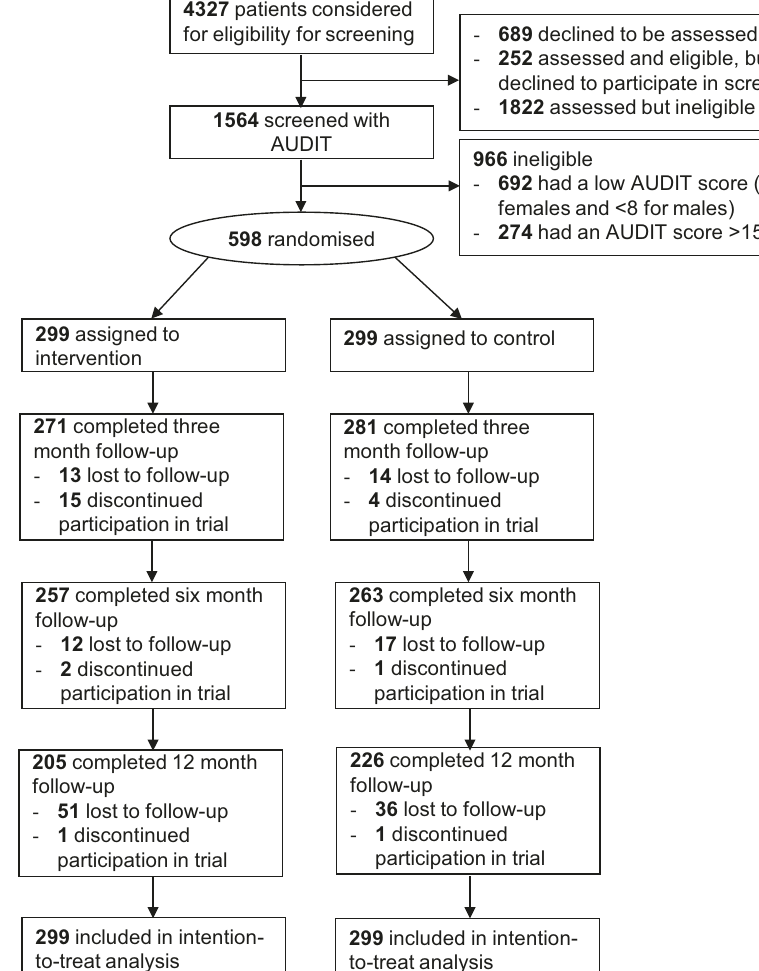
Fig. 1 CONSORT fl ow diagram for YourCall